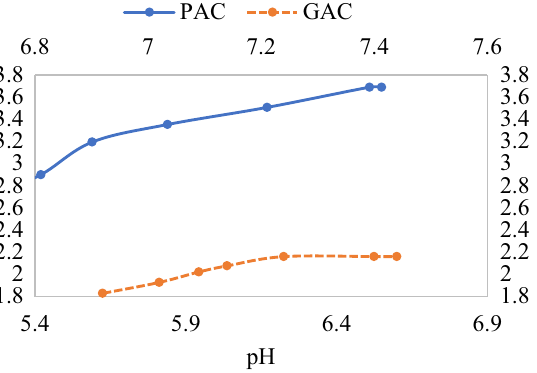
Fig. 4 C t /C o for Hg(II) versus contact